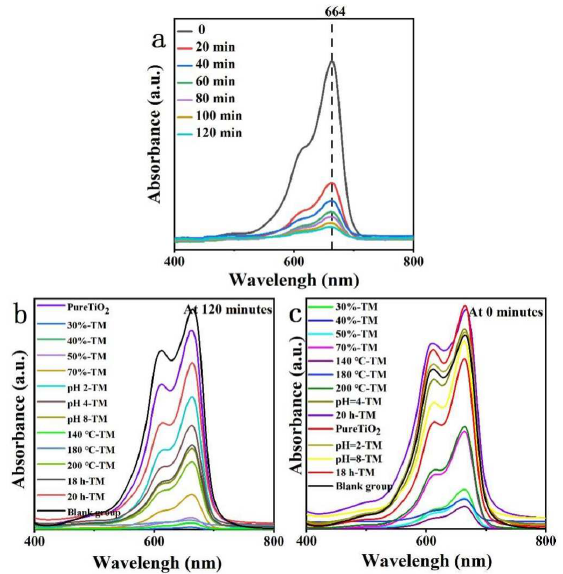
Figure 7. Ultraviolet–visible absorption spectra of methylene blue solutions degraded by ( a ) 30%-TM (degradation time = 0–120 min) and ( b , c ) TiO 2 -MMT composites synthesized under different conditions (degradation time = ( b ) 120 min and ( c ) 0 min).